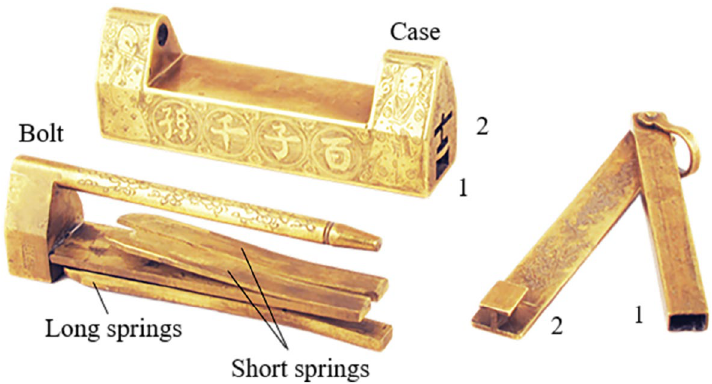
Figure 4. Two-section lock.